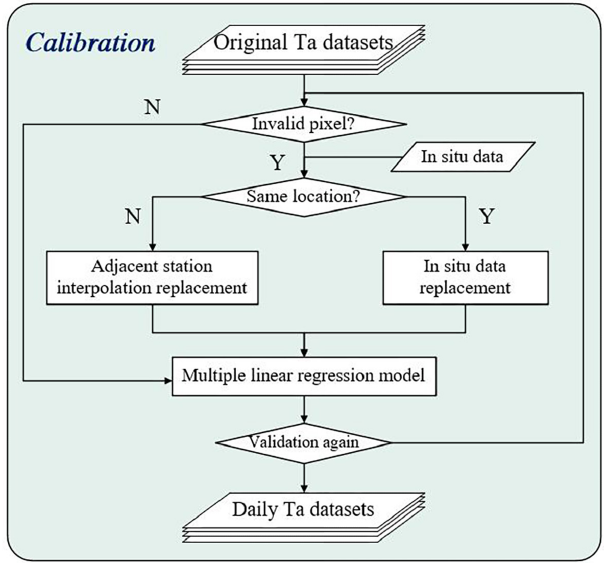
Figure 5. Flowchart for calibration of T a model